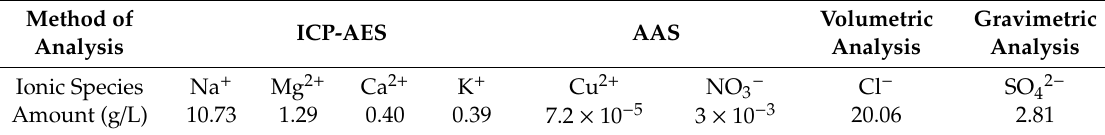
Table 2. Seawater